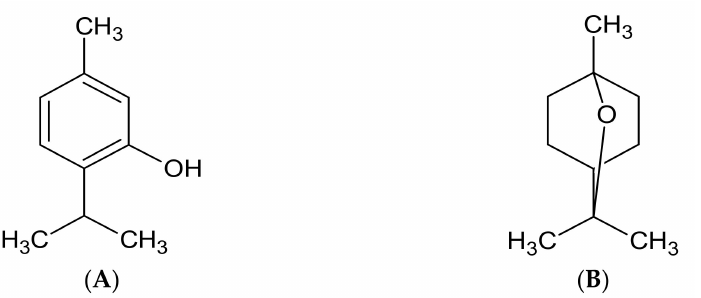
Figure 1. Structure of the major constituents of essential oils of Lippia grata . ( A ) Thymol; ( B )